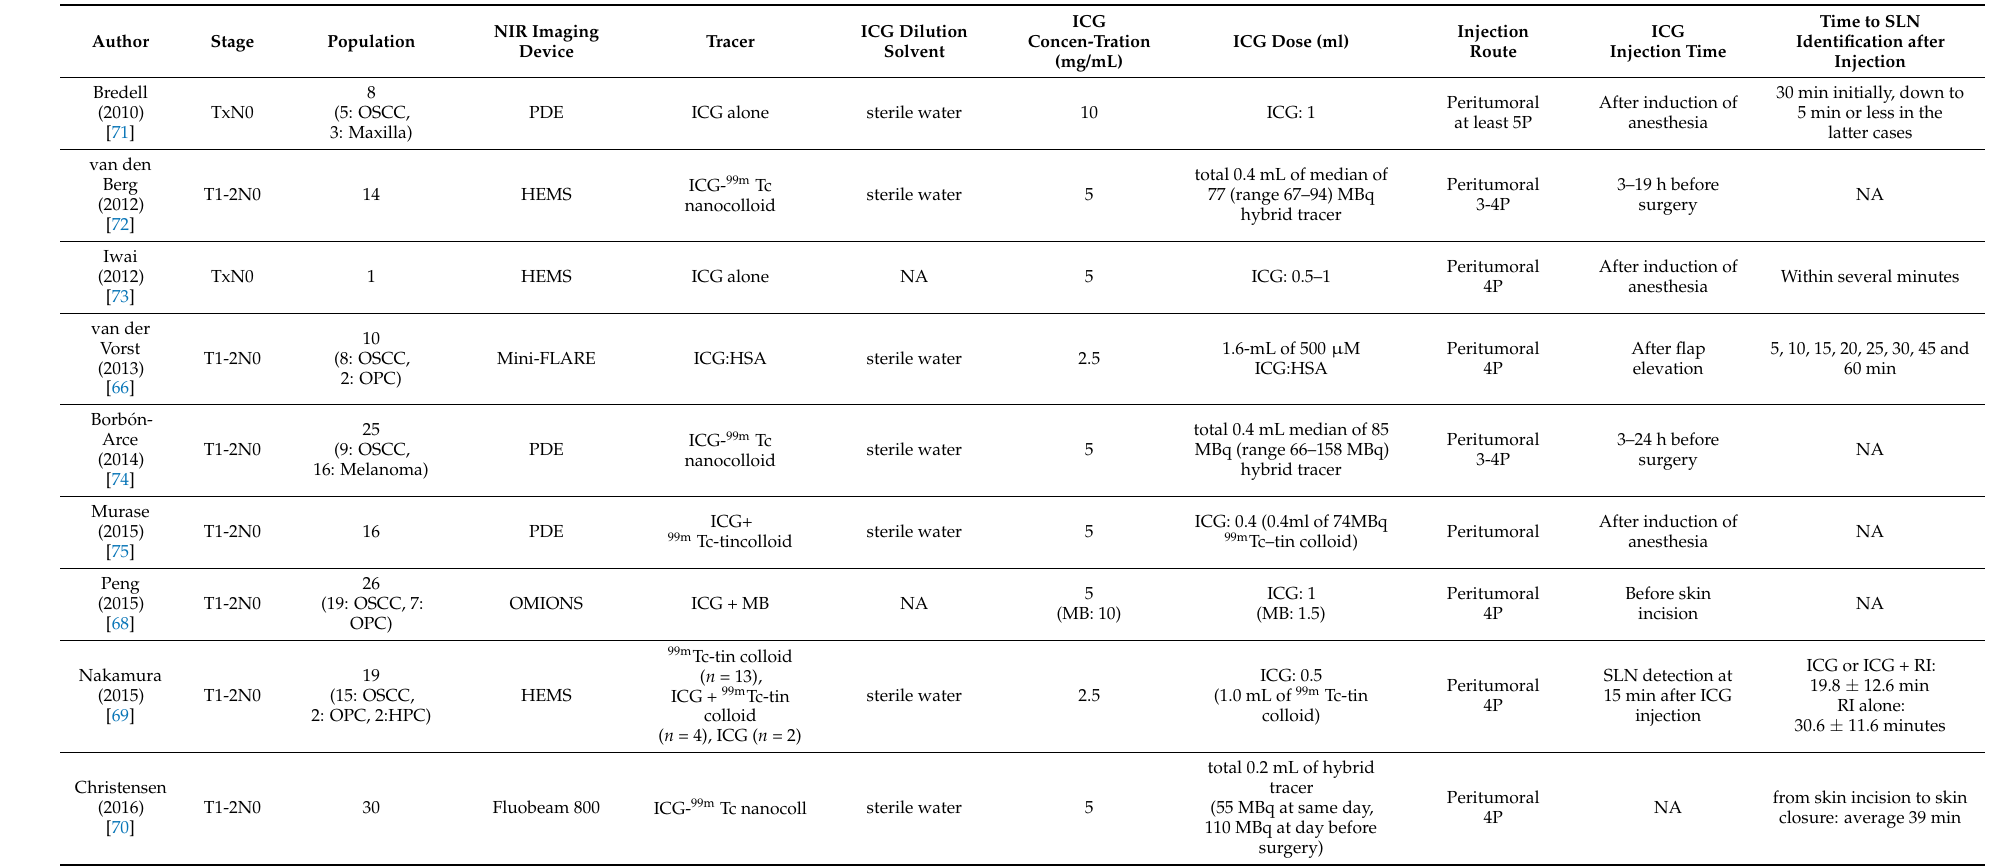
Table 1. Clinical studies of ICG guided sentinel lymph node biopsy in oral